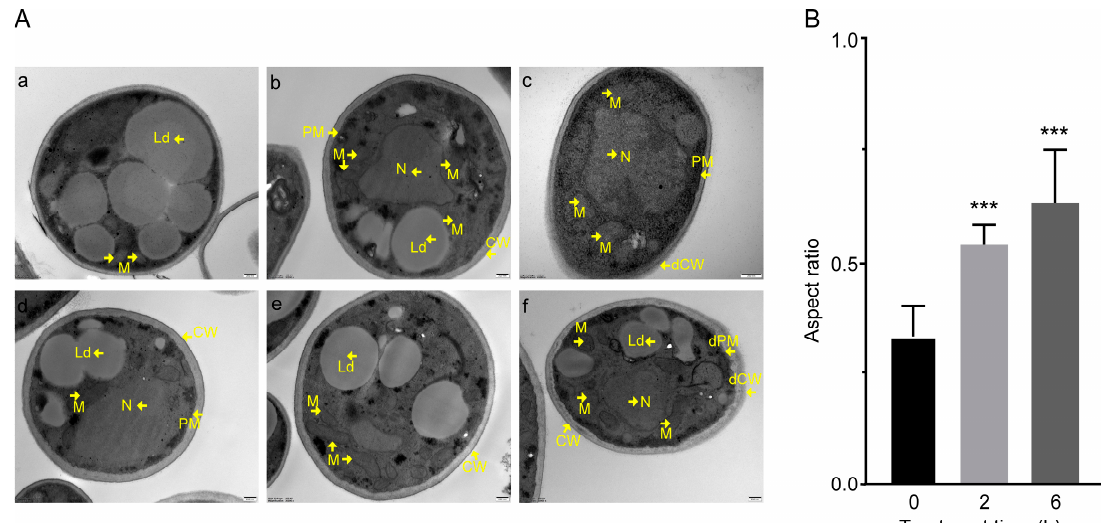
Figure 2. The effect of C17 mycosubtilin at the IC50 concentration on the morphology and structure of different organelles of Vd 991. ( A ). Transmission electron microscope (TEM) images of Vd 991 spores. a, d, untreated Vd 991 spores (control); b, e, Vd 991 spores treated with C17 mycosubtilin for 2 h at IC50 concentrations; c, f, Vd 991 spores treated with C17 mycosubtilin for 6 h at IC50 concentrations. M, mitochondria; N, nucleus; Ld, lipid droplets; CW, cell wall; dCW, damaged cell wall; PM, plasma membrane; dPM, damaged plasma membrane. ( B ). Mitochondrial aspect ratio chart. The aspect ratio of spore mitochondria treated with the IC50 concentration of C17 mycosubtilin for 0 h, 2 h, and 6 h was calculated. At least 30 mitochondria in each group were counted in each experiment, and the experiment was repeated 3 times. Statistical analyses were performed using one-way ANOVA. No less than 30 mitochondria per group were counted, and the values are the mean ± SD. *** indicates extreme significance at p <